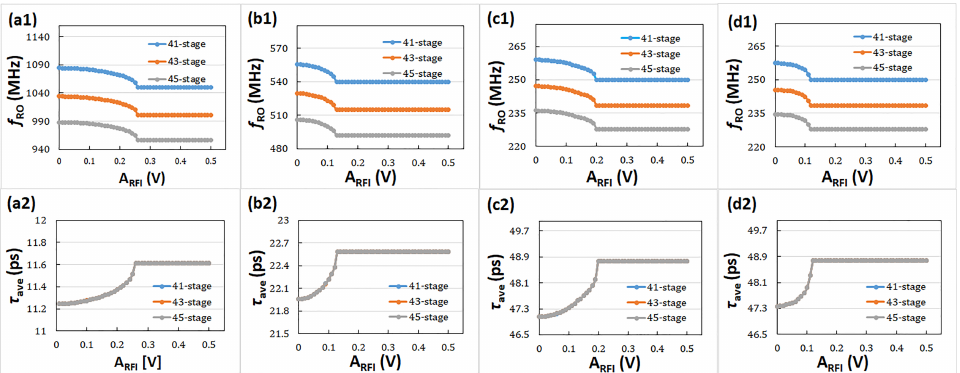
Figure 6. Stage-independent verification of locking: ( a1 ) frequency response of the SMIC-65 nm process; ( a2 ) average gate-delay response of the SMIC-65 nm process; ( b1 ) frequency response of the SMIC-130 nm process; ( b2 ) average gate-delay response of the SMIC-130 nm process; ( c1 ) frequency response of the SMIC-180 nm process; ( c2 ) average gate-delay response of the SMIC-180 nm process; ( d1 ) frequency response of the TSMC-180 nm process; ( d2 ) average gate-delay response of the TSMC-180 nm process.